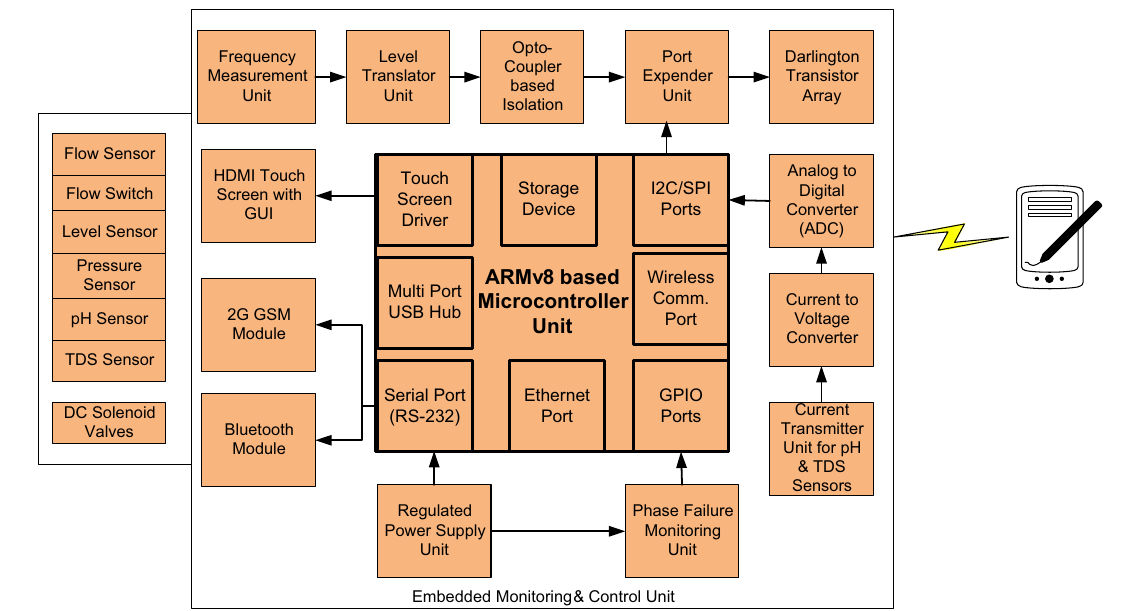
Fig. 2 Functional block diagram of developed embedded RO plant status monitoring unit